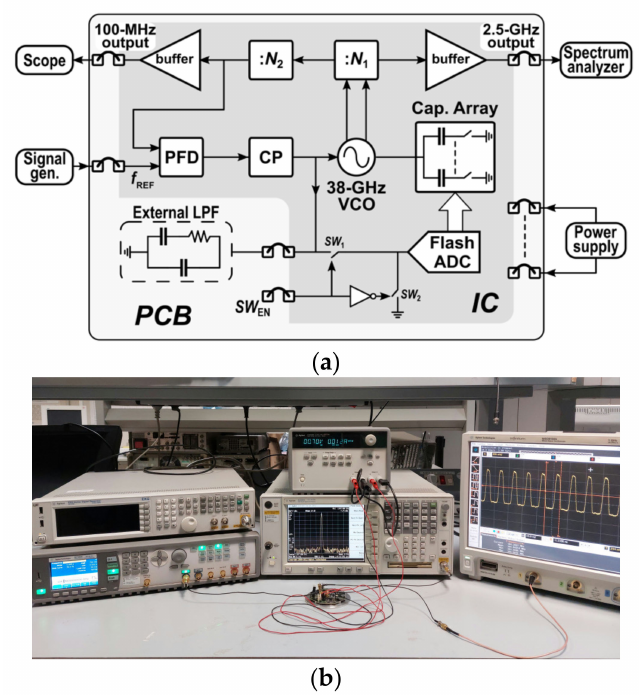
Figure 6. Adopted measurement setup: ( a ) block diagram, ( b )